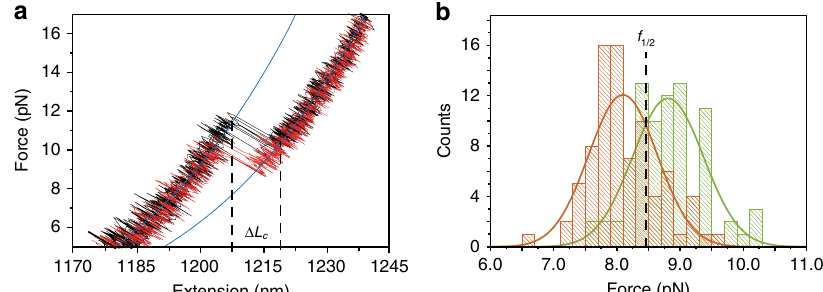
Fig. 2 Determination of breaking forces at each station. a Representative pulling (black) and relaxing (red) curves ( N = 6) recorded at a pulling rate of 200 nm s − 1 displaying WLC behavior of dsDNA handles (blue line). Please, see Methods section for calculation of end-to-end distances. WLC fi t to the contour length increase after the shuttling event gives Δ Lc ~15 nm. b The intersection of the distributions of the breaking forces at fum (green Gaussian fi t) and succ (orange Gaussian fi t) stations reveals the coexistence force, f 1/2 = 8.46 pN ( N = 450